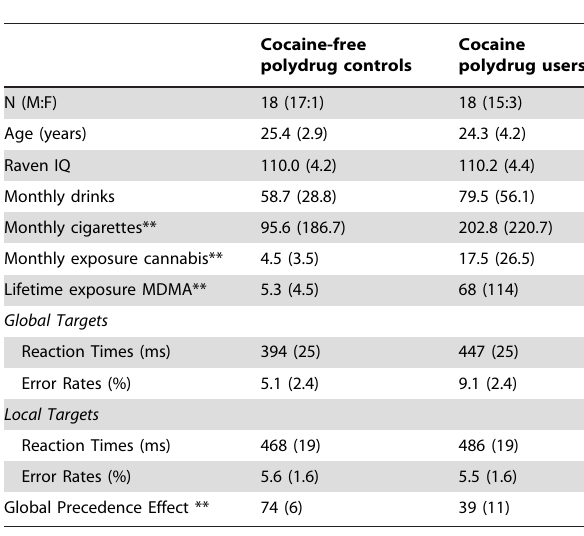
Table 1. Demographic characteristics, use of other recreational drugs and performance on globally and locally defined targets (SEM between